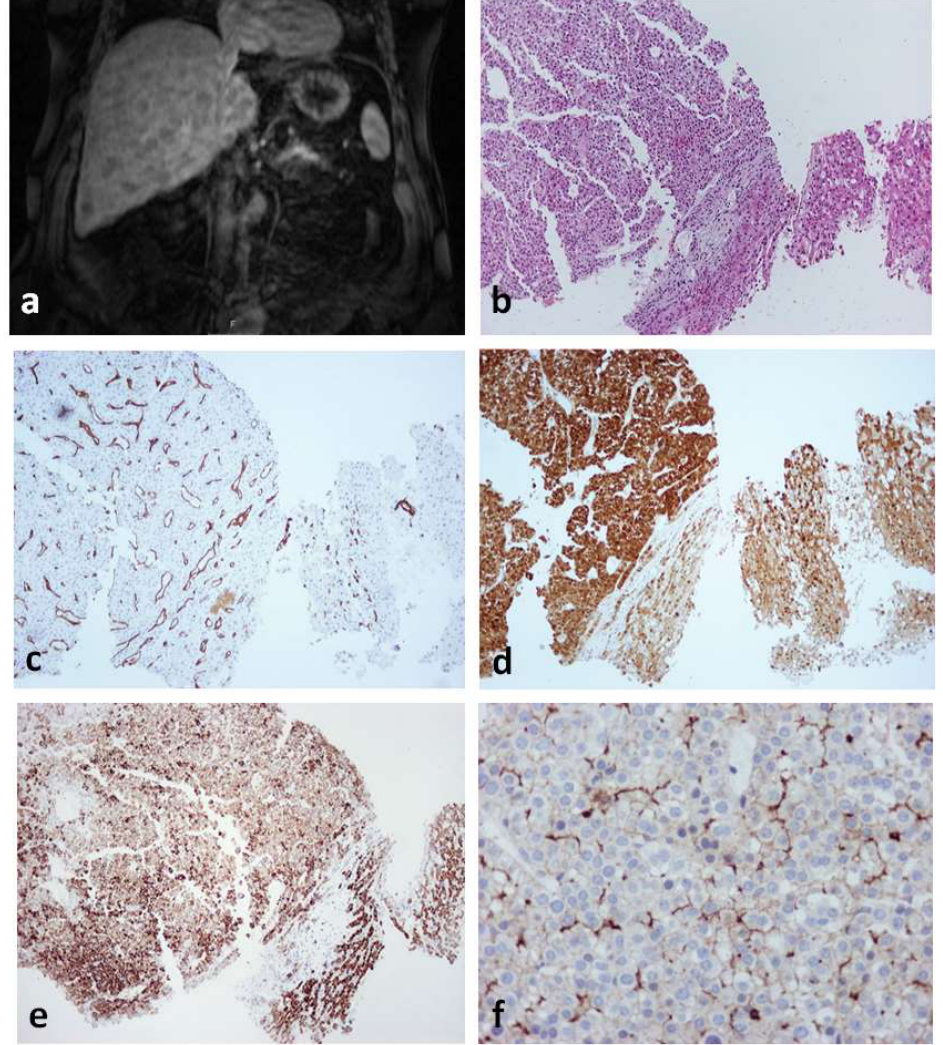
Figure 9. Abdominal MRI ( a ) and guided liver biopsy specimen ( b – f ) from a 53 year old man with breathing difficulty and history of metabolic syndrome, including obesity, type 2 diabetes mellitus, and hyperlipidemia. ( a ) There was marked hepatomegaly with innumerable, scattered nodules, measuring up to 3 cm, suggesting metastatic disease. However, needle biopsy revealed HCC. In this limited biopsy material, polygonal tumor cells appeared to be arranged in a compact sheet ( b , left side ); nevertheless, immunohistochemical stain for CD34 ( c ), highlighting the endothelial cells, demonstrated trabecular architecture. Further stains showed positivity of tumor cells for arginase-1 ( d ) and HepPar1 ( e ). Adjacent hepatocytes ( d , e , right side ) are also positive for these markers, serving as “internal controls”. Tumor cells also displayed a canalicular pattern of staining with pCEA ( f ), as well as positivity for glypican-3 (not shown). FAQ 13—Do immunohistochemical stains or molecular studies provide any action- able items for HCC? Do molecular studies provide any added value in terms of diagnosis or prognosis of HCC, as compared to standard immunohistochemical stains?